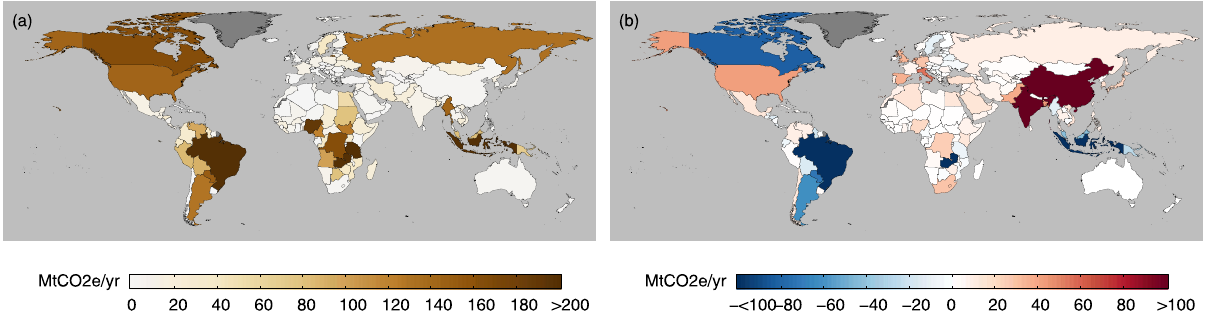
Fig. 5 Agricultural land-use emissions for 2015. Left panel ( a ) shows agricultural land use emissions without trade adjustments. Right panel ( b ) shows the differences between trade-adjusted agricultural land-use emissions and agricultural land-use emissions. Differences are calculated such that the larger the positive difference (darker red), the higher is a country ’ s trade-adjusted agricultural land use emissions (i.e., net importers of land-use emissions). Likewise, the larger the negative difference (darker blue), the lower is a country ’ s trade-adjusted agricultural land use emissions (i.e., net exporters of land-use emissions). Dark grey colours indicate countries with no available data (e.g., Greenland). Per capita emissions and differences are shown in